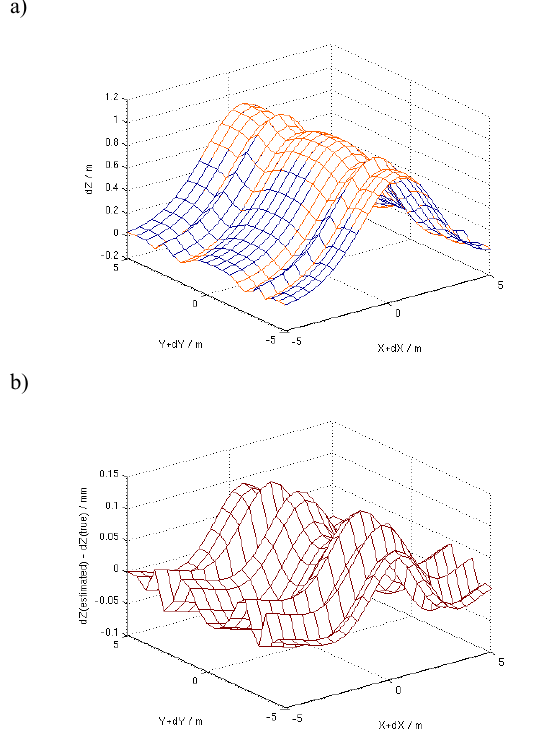
Figure 2. a) Estimated and true deformation in red and blue, respectively, for the deformation in Eq. 7 with weak imaging geometry. b) Difference between the estimated and true Z coordinates of the deformation in millimeters.